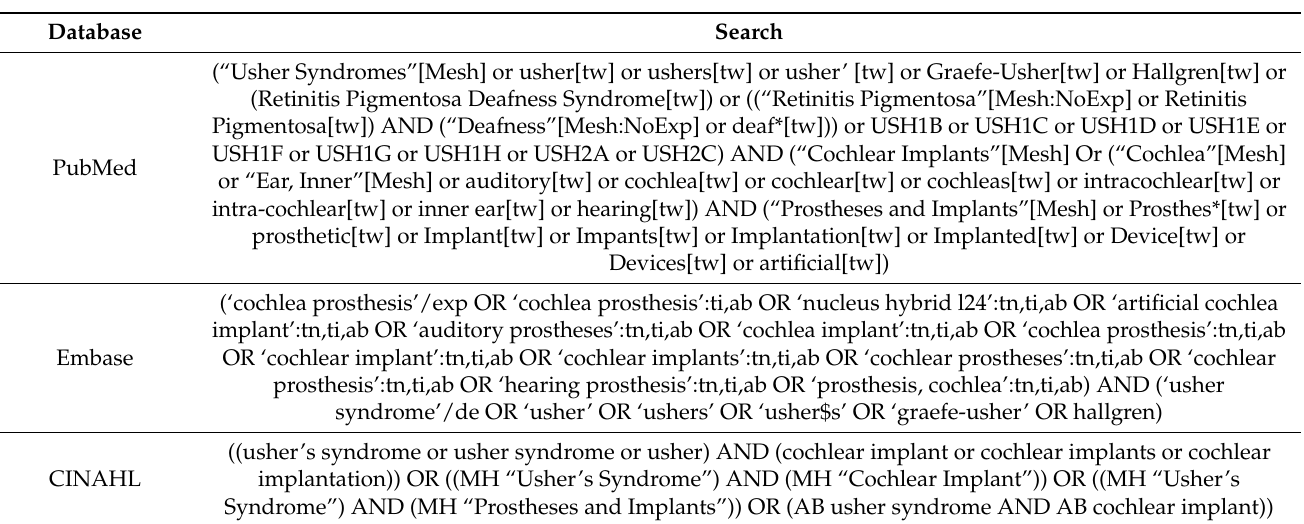
Table 2. A Summary of Literature Searches